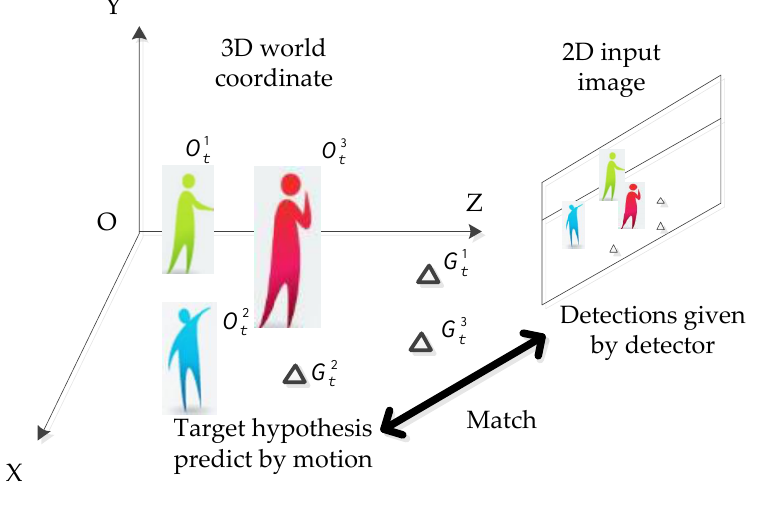
Figure 3. Observation likelihood model.